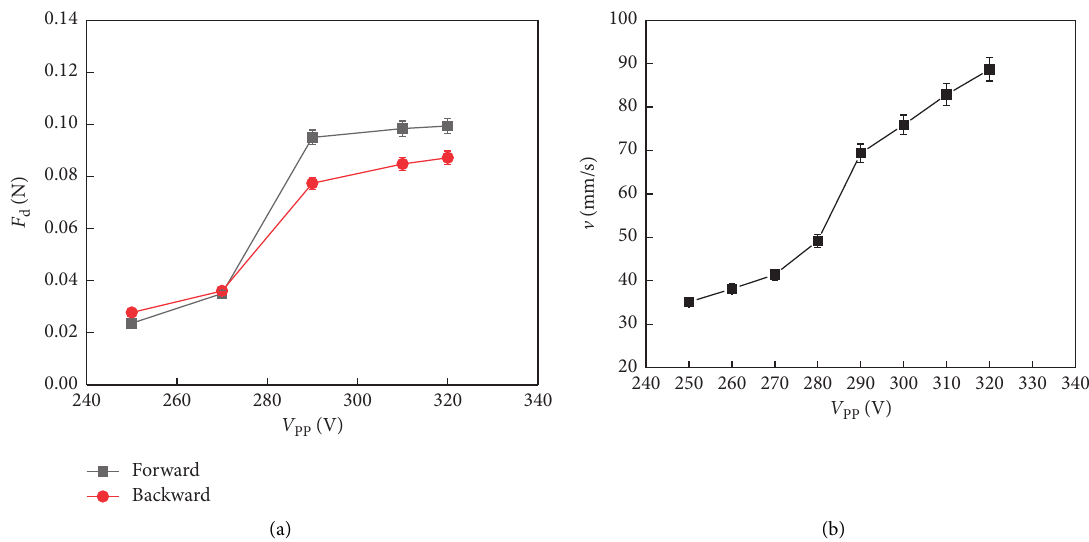
Figure 17: Variation of stall force and average velocity with V